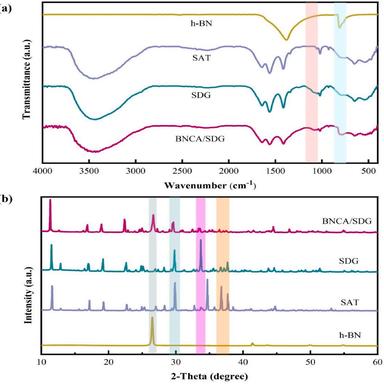
The chemical and crystal structures of samples. (a) FR-IR spectroscopy; (b) XRD pattern.